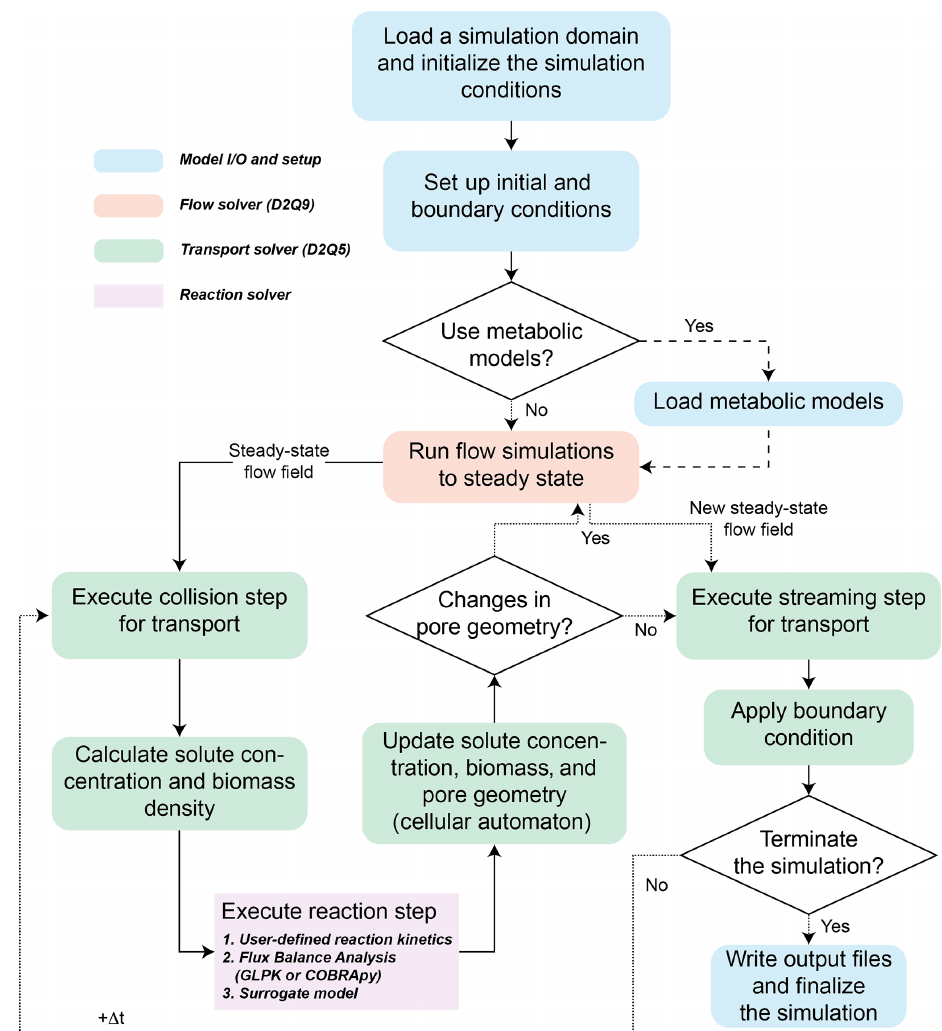
Figure 1. Flowchart of CompLaB for reactive transport simulations. Changes in pore geometry are assessed due to biomass changes. The state variables involved in the reactions can represent dissolved chemicals and planktonic microbes and solid phases or sessile